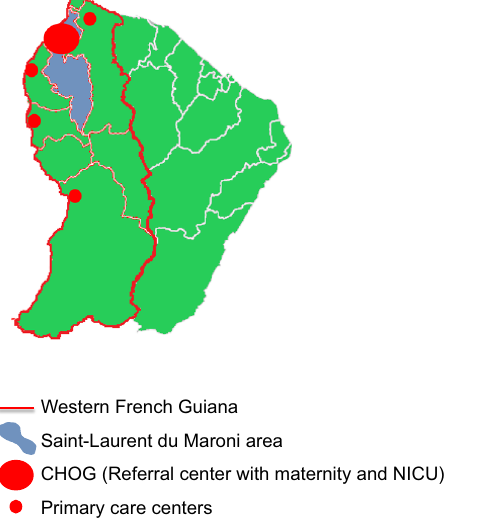
Fig. 5 Healthcare services in western French Guiana. All newborns from Zika-infected mothers, living in western French Guiana (within the red lines) and followed at the pediatric clinic of the CHOG (large red dot), were enrolled in this cohort. Asymptomatic neonates from mothers living outside of the Saint-Laurent du Maroni area (blue area), were discharged after